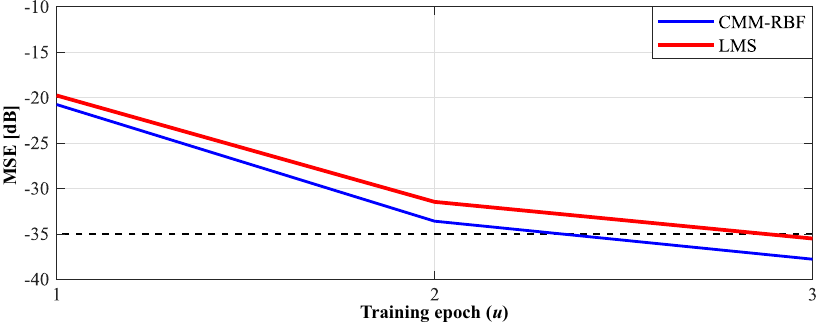
Figure 8. Mean squared error (MSE) of the complex multiple-input multiple-output radial basis function neural network (CMM-RBF) and least mean square (LMS) algorithms for three training epochs: 2D-grid array (2D-GA) with target ˆ ω = 160 ◦ .